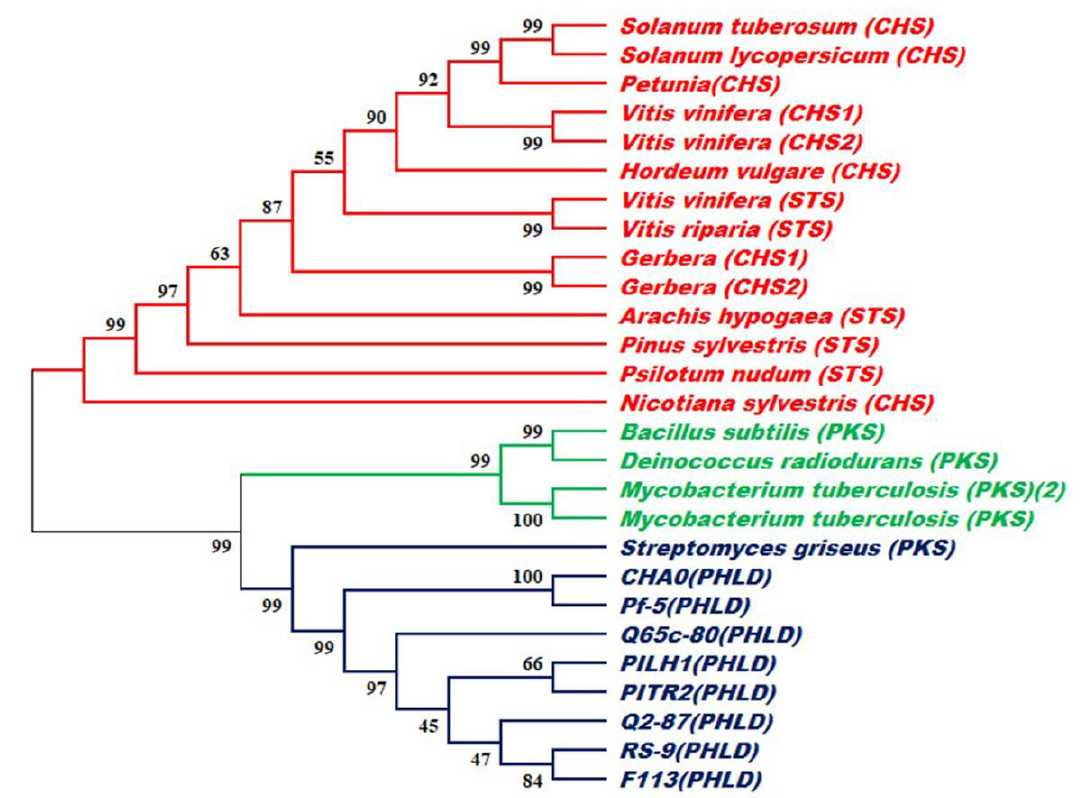
Figure 8. Diversity analysis between predicted amino acid sequences of PHLD from eight Pseudomonas strains and type III polyketide synthase from gram-positive bacteria (PKS) and plants (CHS/STS). The maximum likelihood (ML) tree was generated by the neighbor-joining method implemented in MEGA10.